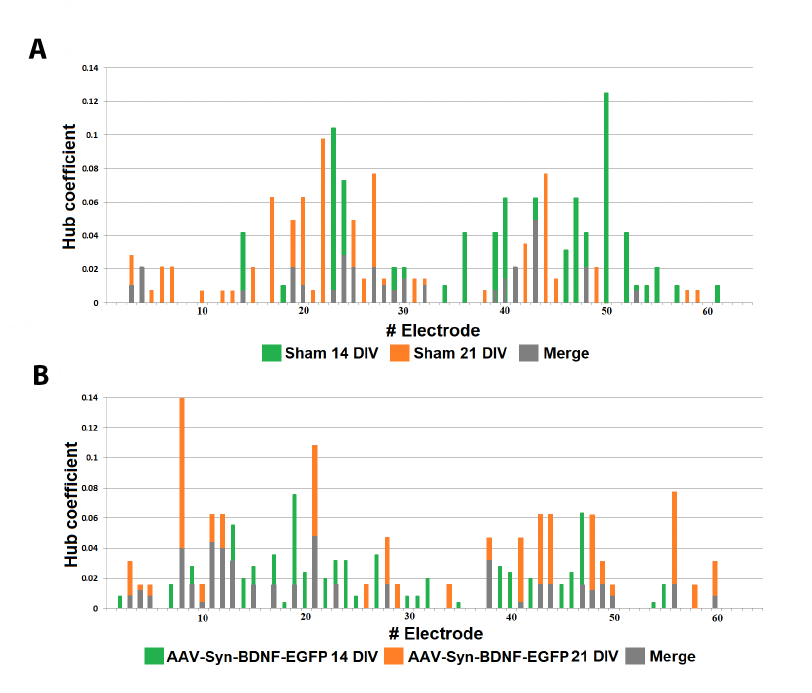
Figure 4. Functional rearrangement alterations of neural networks during the 14–21 DIV period. The hub coefficient was calculated as the ratio of the number of connections of an electrode to its total number in the graph and therefore characterizes the importance of a group of neurons located at one electrode for network activity. Plotting the hub coefficients allows estimation of the changes in the significance of each electrode in a multi-electrode array. A —sham; B —AAV-Syn-BDNF-EGFP.